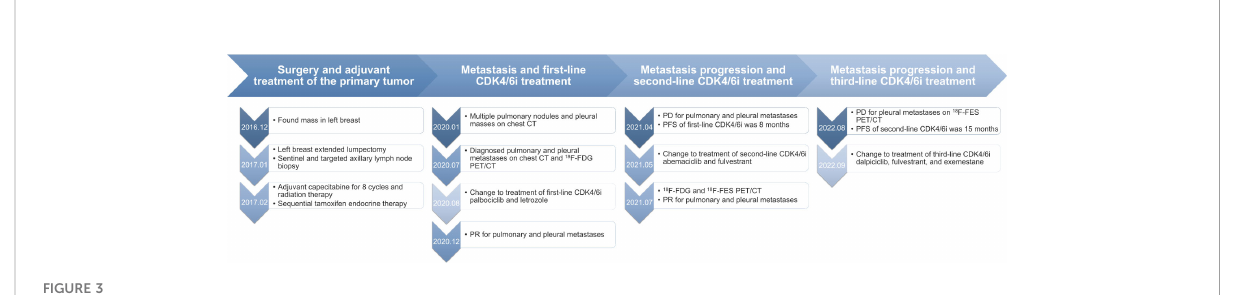
FIGURE 3 Timeline of the patient ’ s disease progression.